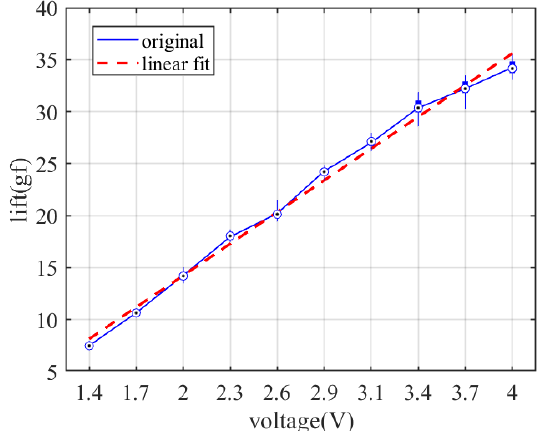
Figure 17. Lift–voltage relationship of flapping wing mechanism.